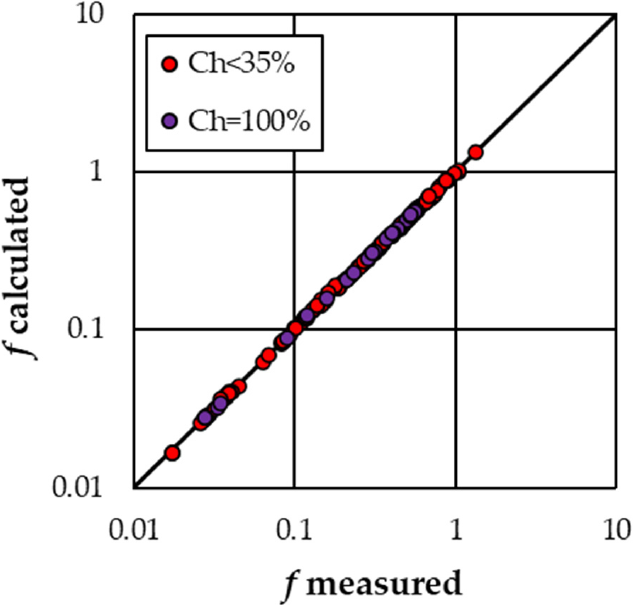
Figure 5. Comparison between the measured f m values and those calculated f c by Equations (11) for the “Transversal stripe” arrangement.